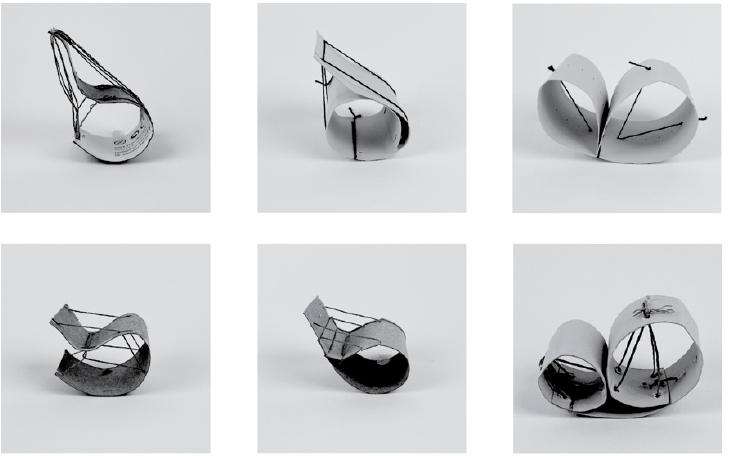
Figure 6. Paper–string prototypes demonstrating how timber (paper) could be used in compression, and flax FRP (string) in tension.